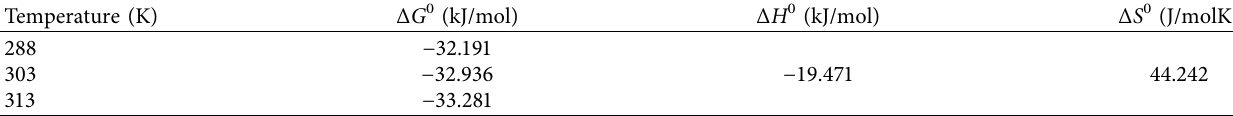
Table 7: Thermodynamic parameters for the adsorption of Murexide onto activated carbon.